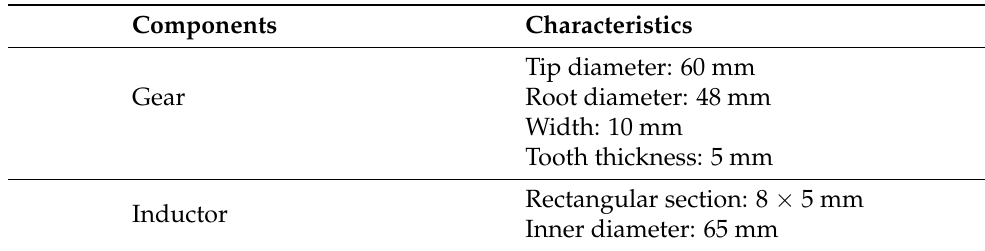
Table 1. Dimension of the gear and the inductor.